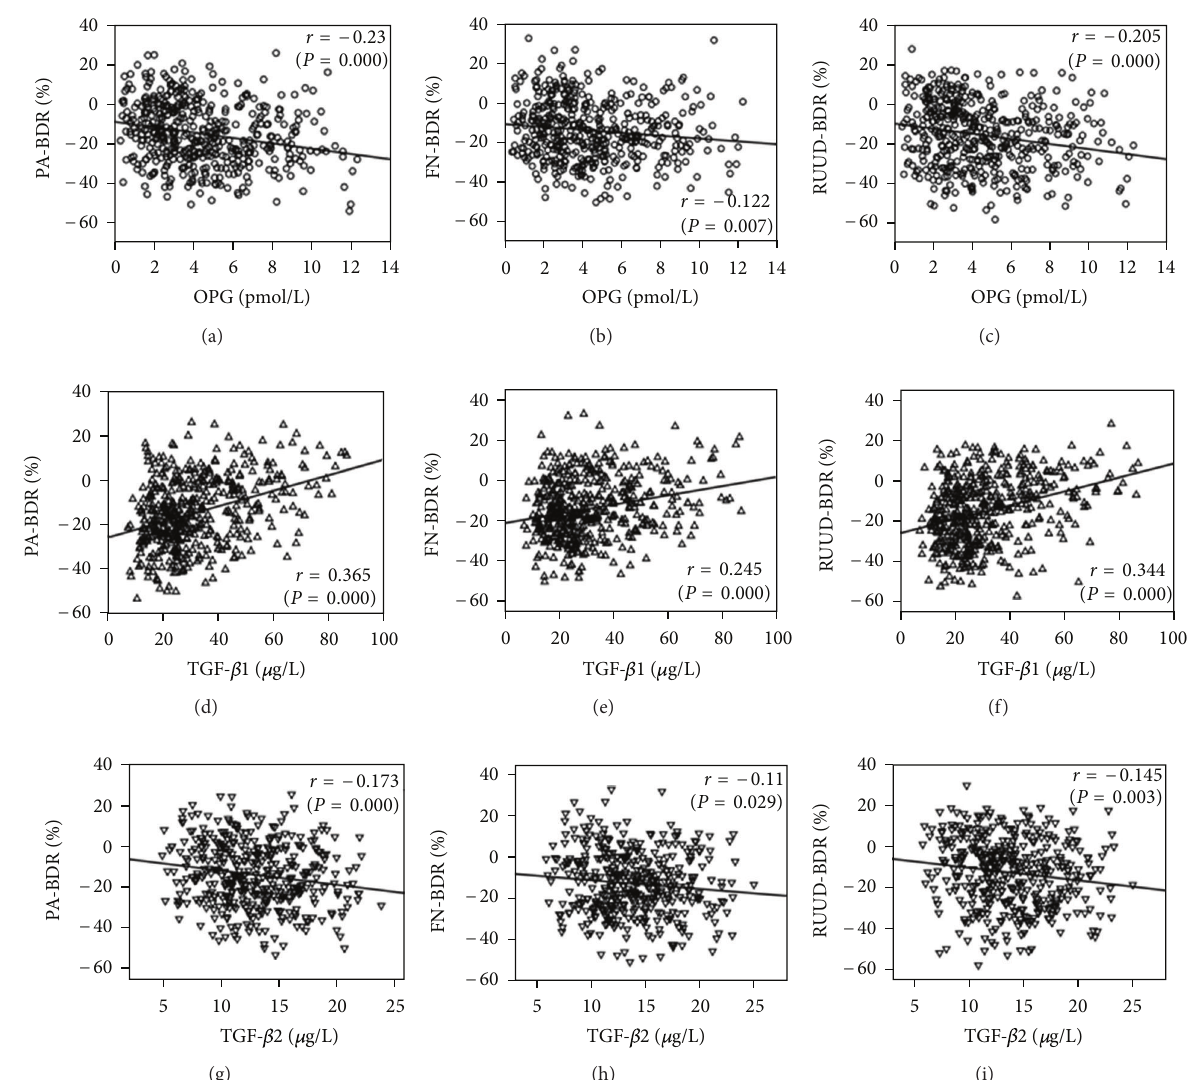
Figure 1: Scatter plots of serums OPG, TGF- 𝛽 1, and TGF- 𝛽 2 concentration versus BDR at various skeletal sites in native Chinese women. OPG: osteoprotegerin, TGF- 𝛽 : transforming growth factor-beta, BDR: bone mineral density decrease rate, PA: posteroanterior spine, FN: femoral neck, and RUUD: radius + ulna